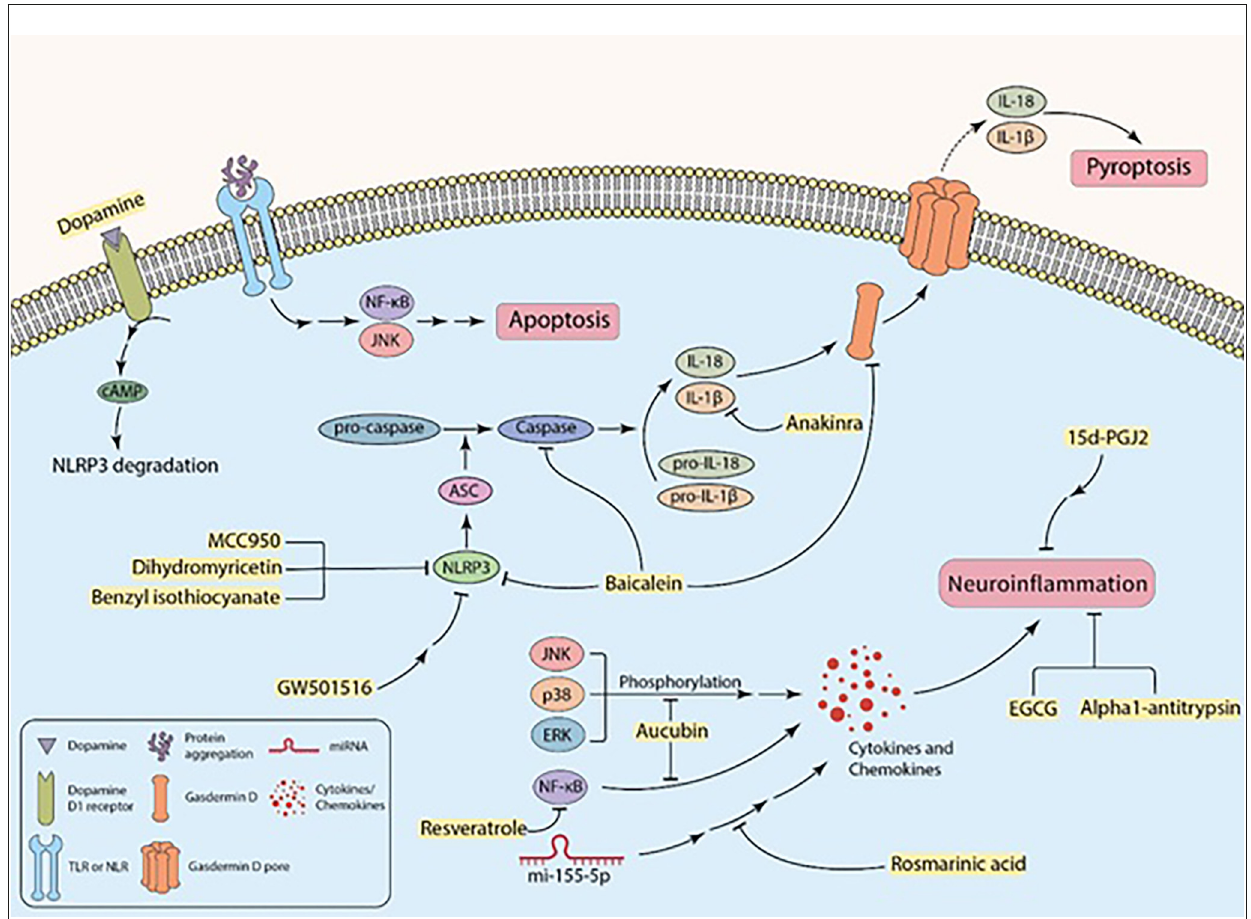
FIGURE3 The possible role of inhibiting inflammatory factors to attenuate neuroinflammation-induced neuronal cell death.